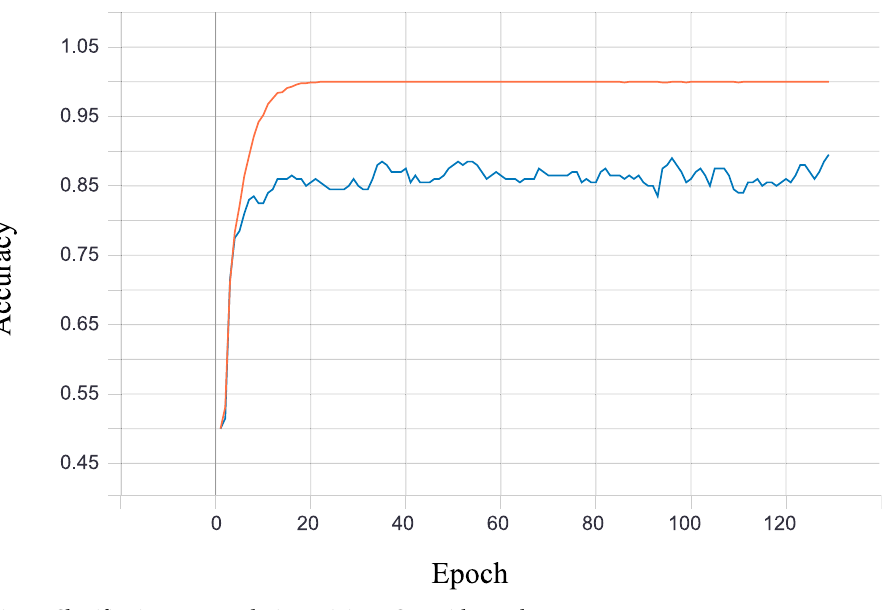
Fig 10. Classification accuracy during training—Case with two classes.